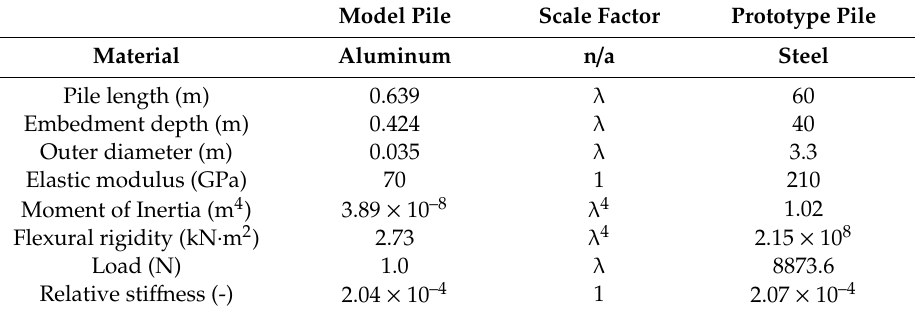
Table 2. Pile specification.